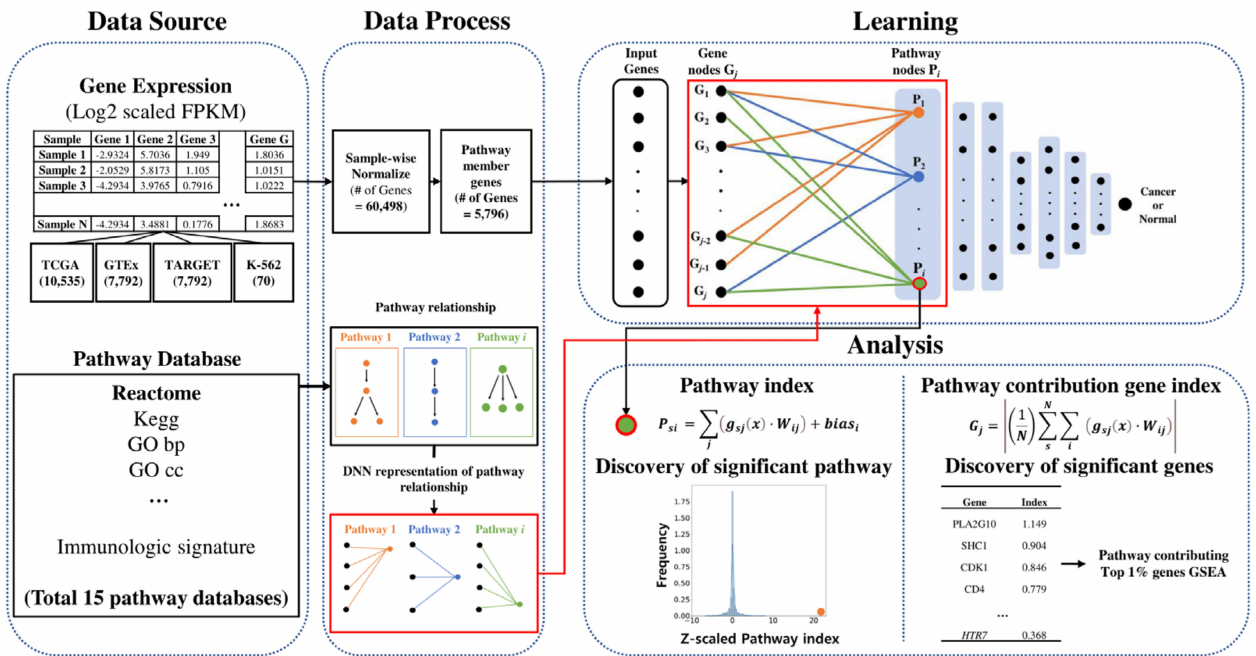
Figure 6. Data processing and analysis